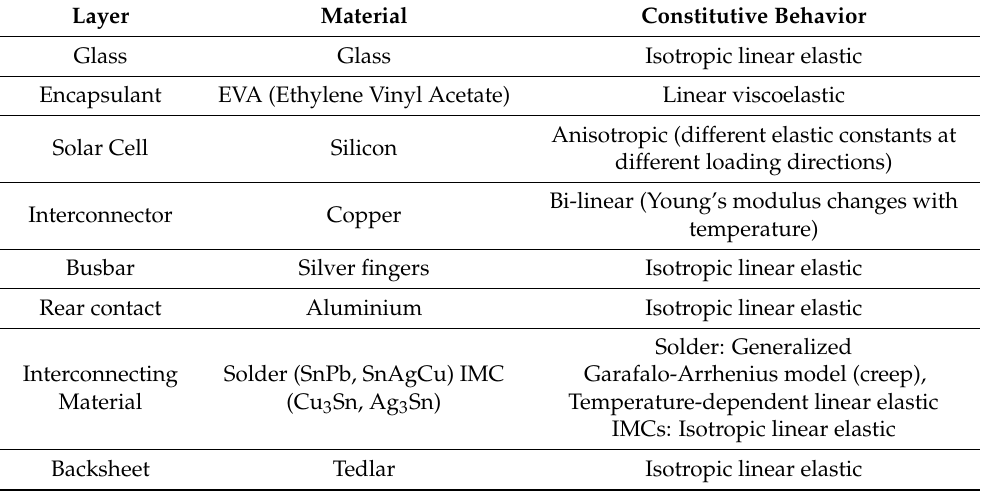
Table 1. Solar Cell Material constitutive model.